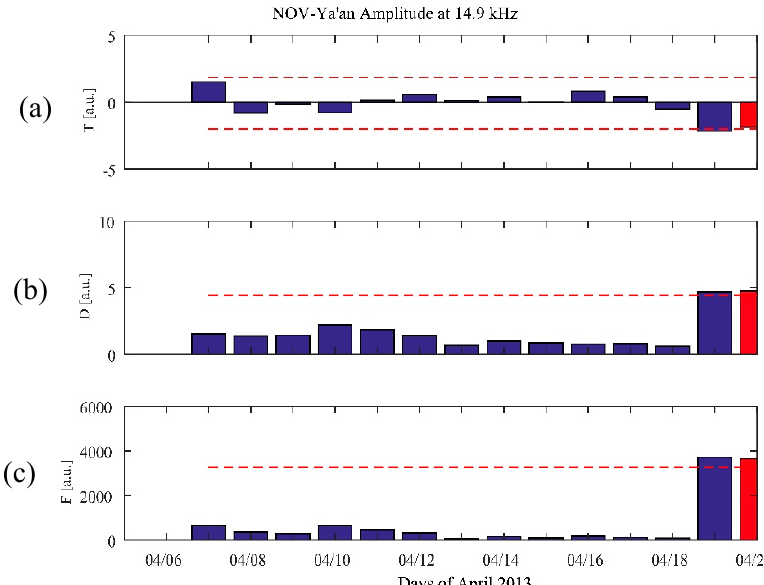
Figure 7. Nighttime fluctuation analysis for the Lushan earthquake on 20 April 2013 is shown in red. The trend (T) ( a ), dispersion (D) ( b ), and fluctuation (F) ( c ) between NOV and Ya’an at F3 are shown separately. The horizontal line in each panel depicts the 2 σ deviation criterion that defines the anomalous day.